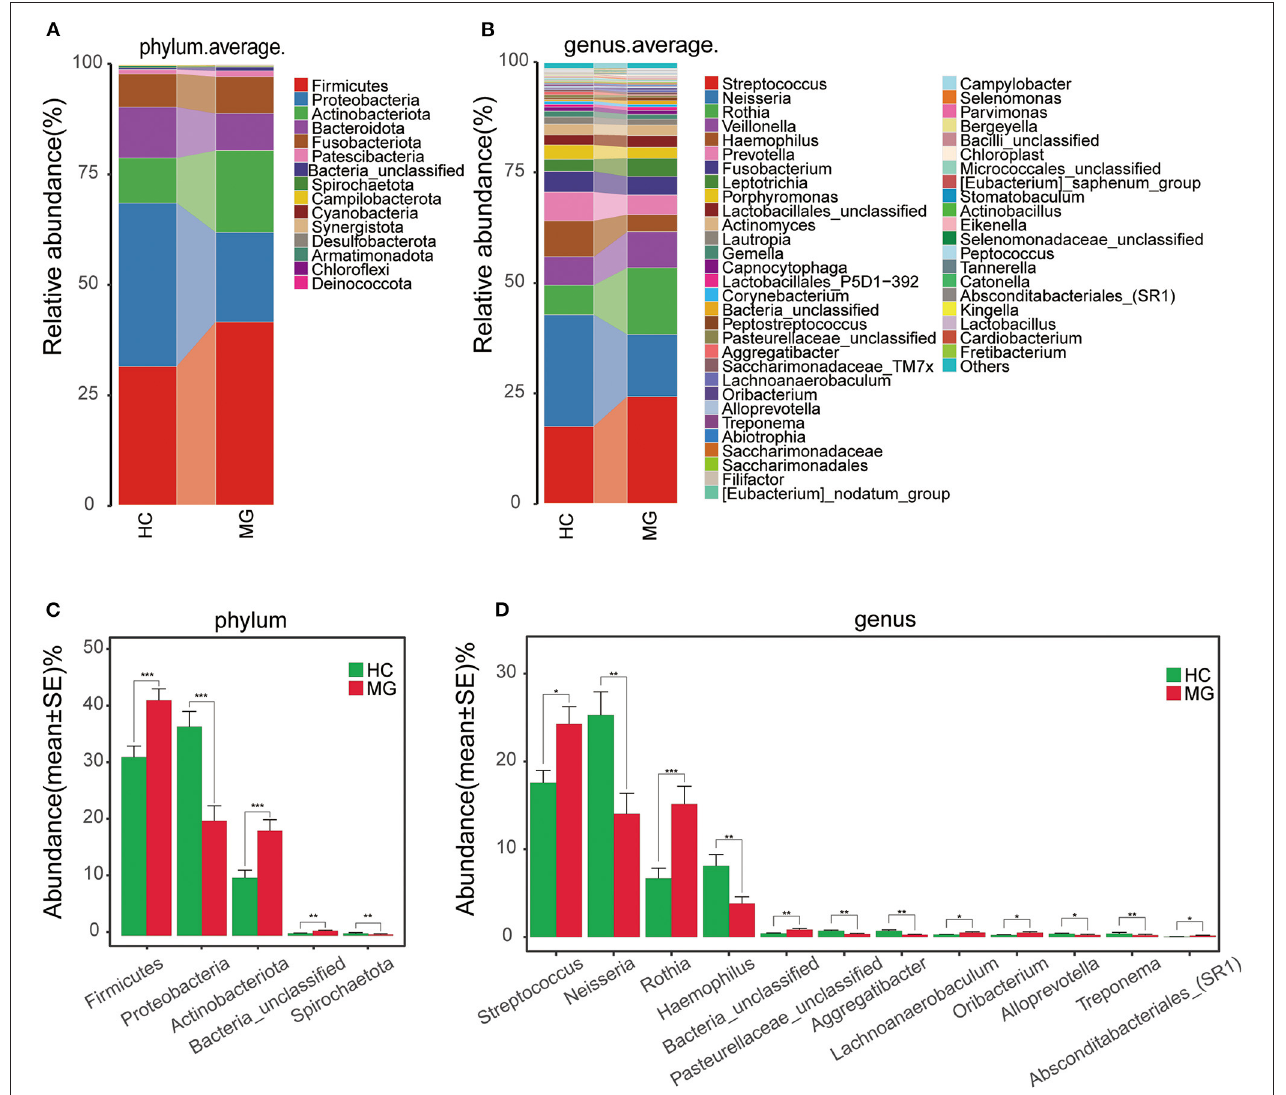
FIGURE 2 | Composition and comparison of oralmicrobiomes in MG ( N = 20) and HC ( N = 20) groups (A,B) Composition of oral microbiota at the phylum (A) and genus (B) levels in MG vs. HC (C,D) Distribution of differential microbiota at the phylum (C) and genus (D) levels. Significant differences were observed in the abundance of predominant genera between MG (red) and HC (green) groups. The average abundance of each bacterial species is presented as mean ± SE. P -values were calculated with the Mann–Whitney U-test.* P < 0.05; ** P < 0.01; *** P < 0.001. compared between groups by PCoA based on a